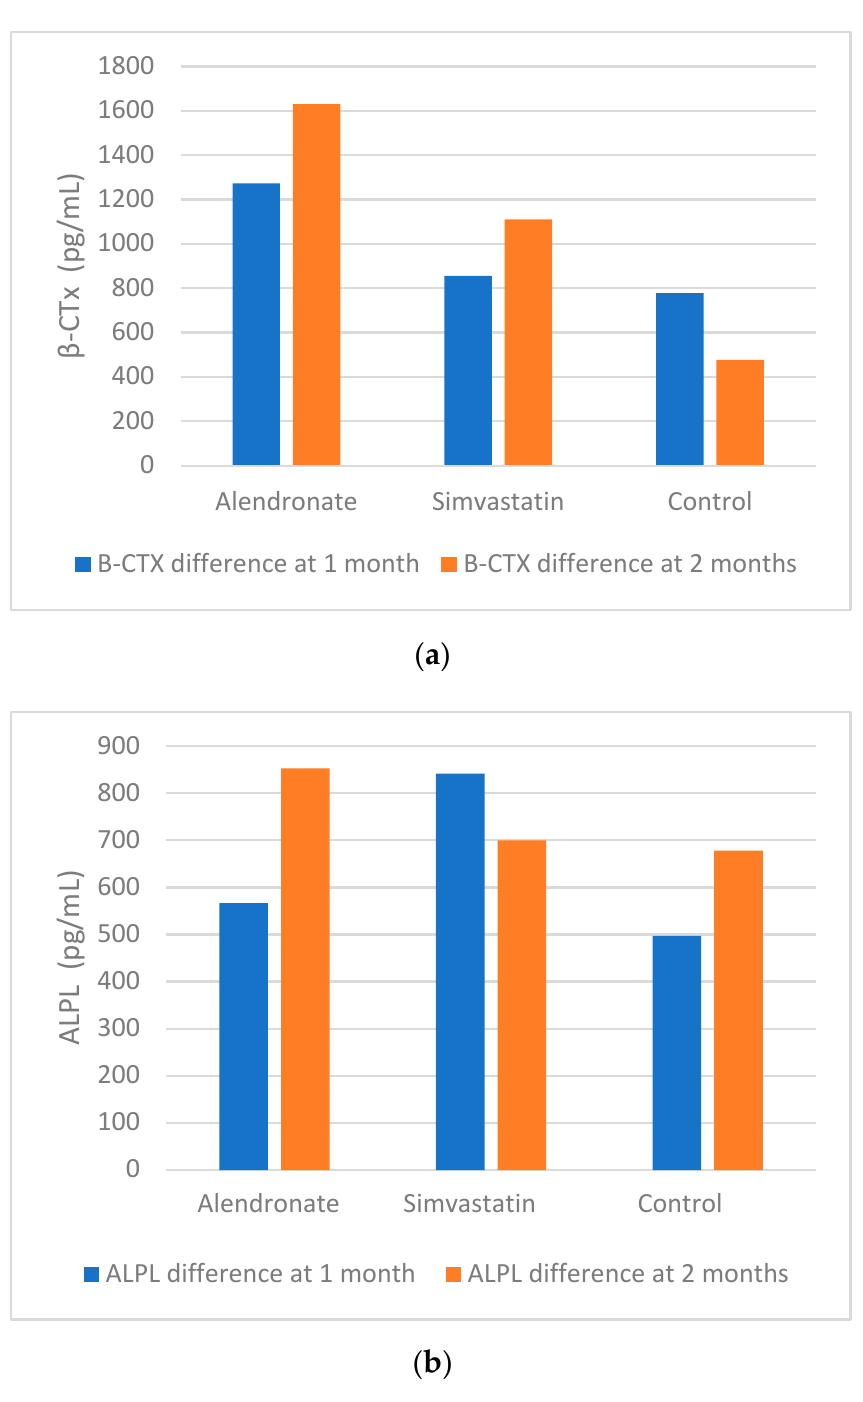
Figure 7. Comparison of β -CTx ( a ) and ALPL ( b ) levels difference from baseline at one and two months postoperatively.